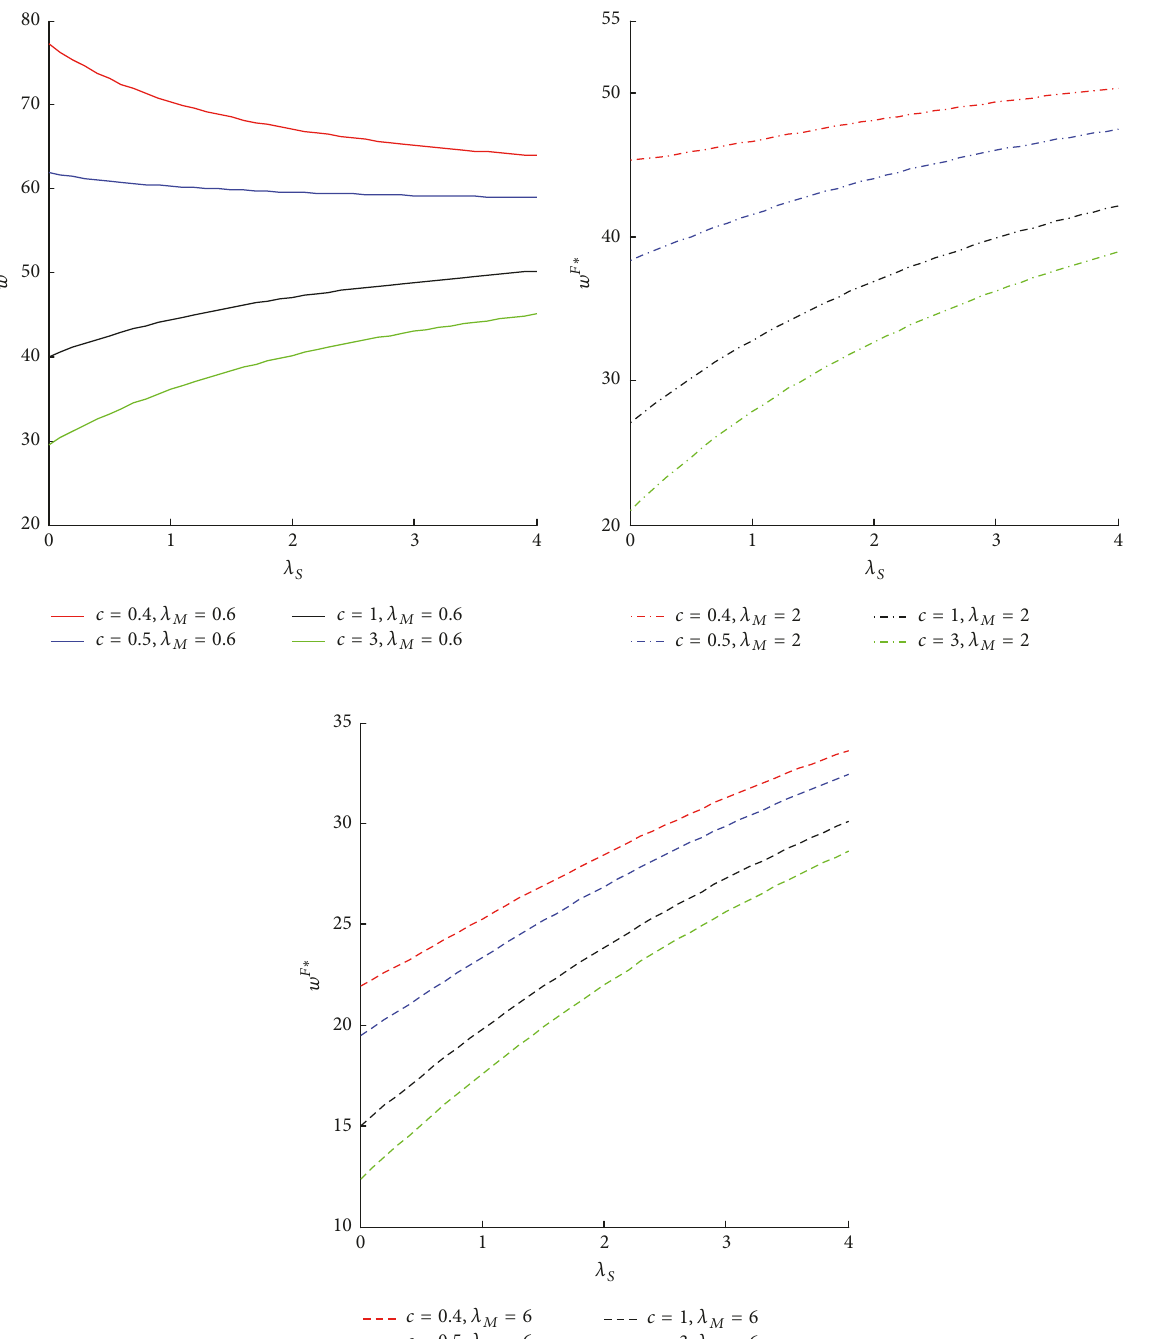
Figure 2: Effects of 𝜆 𝑆 on the equilibrium wholesale price (𝑎 = 600 , 𝛼 = 8 , 𝛽 = 10 , V 𝑆 = 3 , V 𝑀 = 2 , 𝜏 = 0.6 , 𝜀 = 0.4) .